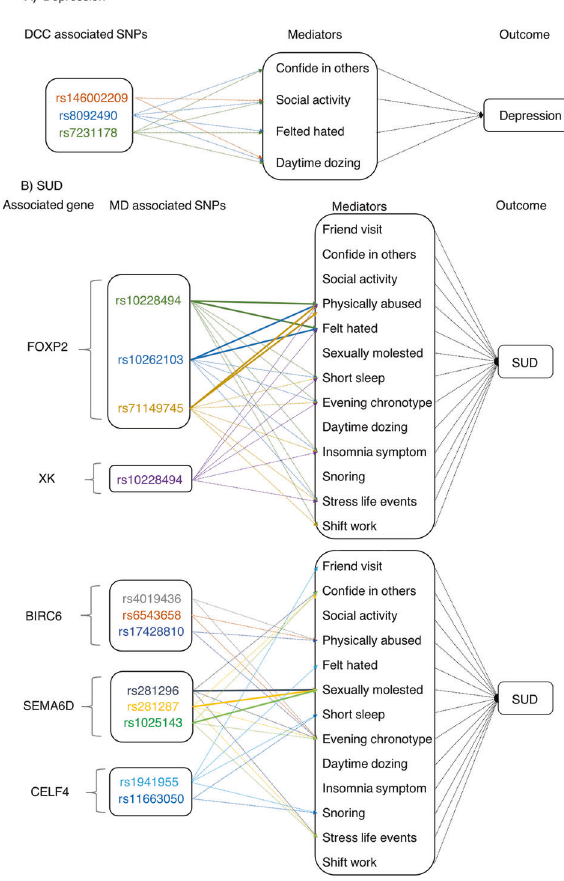
Fig. 2 Mediation analyses results for environment factors. *Fig. 2 shows the environment factors play a mediating role between MD associated SNPs and MD diseases, including depression ( A ) and SUD ( B ). A virtual arrow represents a partial mediation and a solid arrow represents a full mediation. MD, mental disorders. MD, mental disorders; SUD, substance use